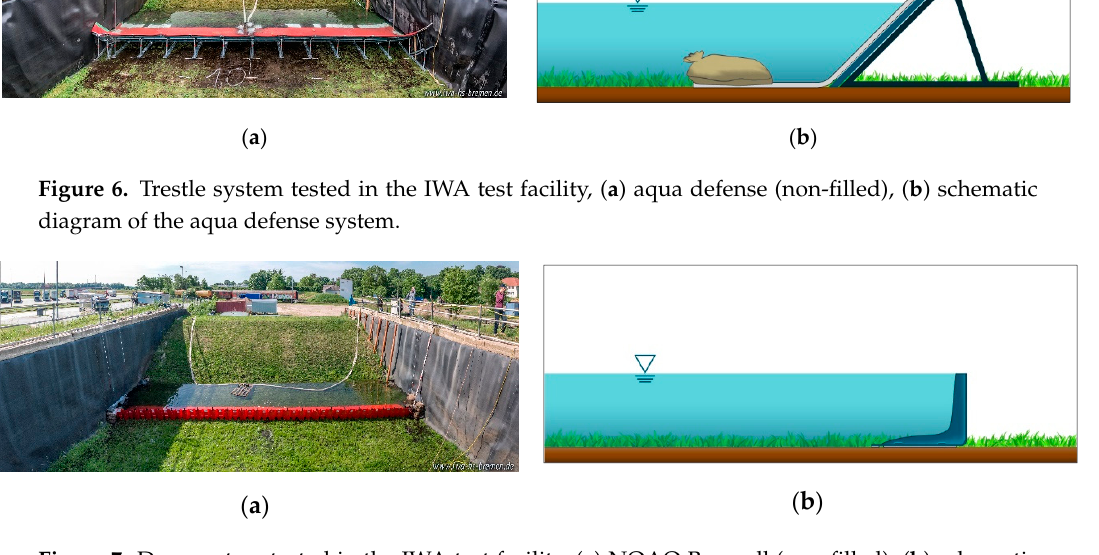
Figure 7. Dam system tested in the IWA test facility, ( a ) NOAQ Boxwall (non-filled), ( b ) schematic diagram of the NOAQ Boxwall system.